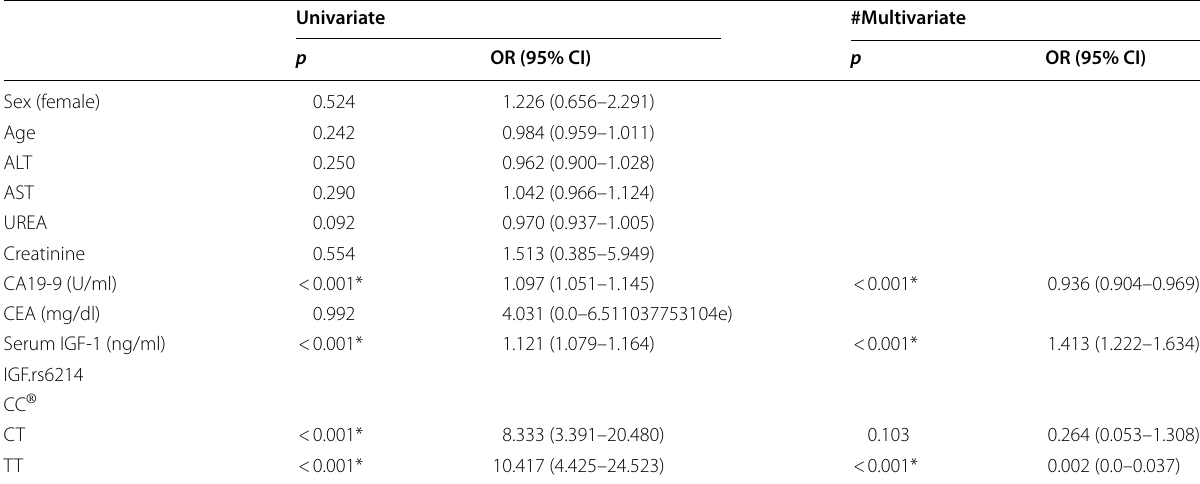
Table 6 Univariate and multivariate analysis for the risk factor of colorectal cancer